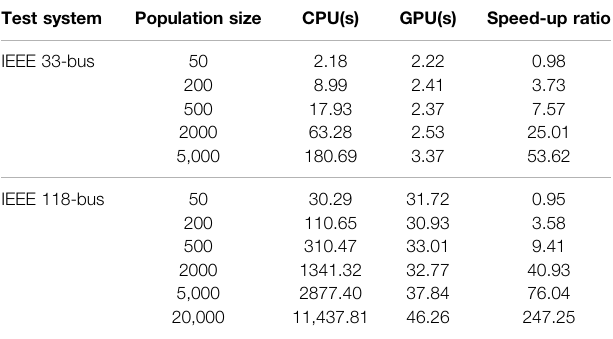
TABLE 2 | Computing time of CPU platform and GPU platform with different populations (IEEE 33-bus system and IEEE-118-bus system). Test system